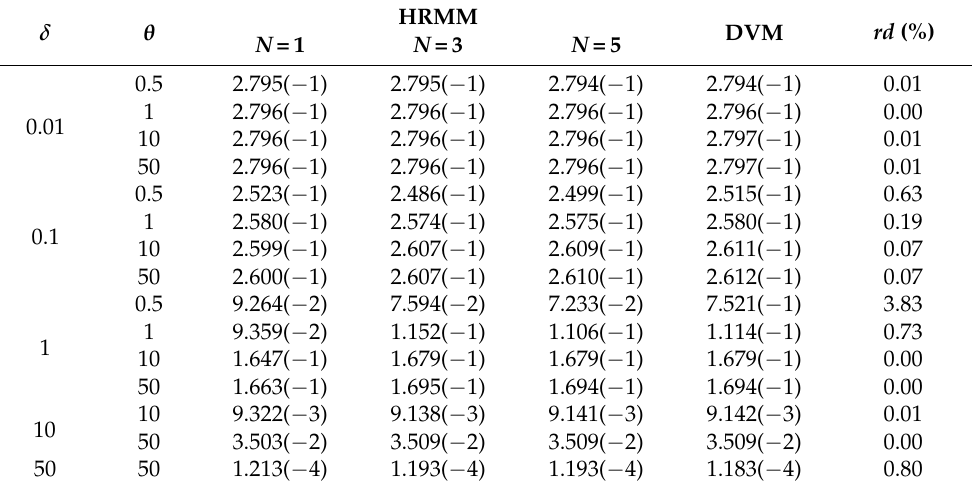
Table 6. Oscillatory Couette flow; shear stress amplitude at the stationary wall p xy,A ( y = H ) for various values of δ and θ based on the HRMM, with N = 1,3,5 and the DVM, along with the relative difference between corresponding results.